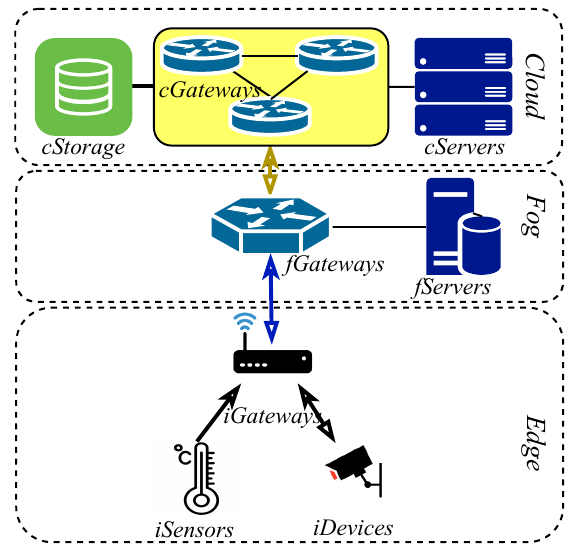
Figure 3. A typical architecture of IoT smart factory integrated with Cloud–Fog